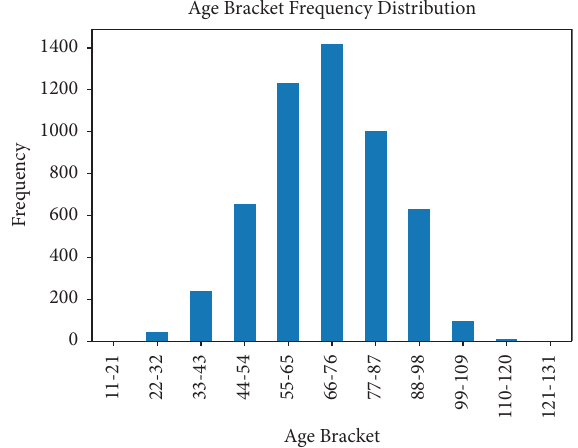
Figure 1: Age bracket